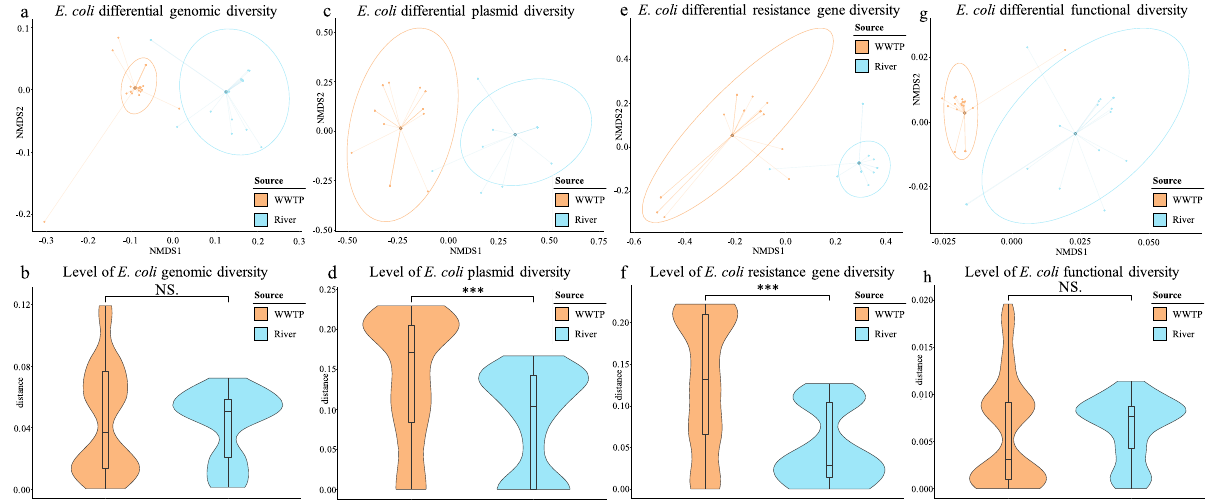
Fig. 3 Non-metric multidimensional scaling (NMDS) and violin plots according to Jaccard distance index and the environment (WWTP and river, indicated by colors). NMDS graphs show the differential content in the total wastewater E. coli population ( n = 25 independent isolates) and river E. coli population ( n = 18 independent isolates), indicating the centroids for the means of each group and clustering them by colored ellipses. Violin plots show medians and quartiles for diversity levels per E. coli ST, comparing them by the origin of the isolates. Highly signi fi cant differences are indicated by ***. Non- signi fi cant differences are indicated by NS. a Differential genomic content based on core-genome analysis. b Level of genomic diversity per E. coli ST based on core-genome analysis. c Differential plasmid content based on plasmid incompatibility groups. d Level of plasmid diversity per E. coli ST based on plasmid incompatibility groups. e Differential antibiotic resistance gene content. f Level of antibiotic resistance gene diversity per E. coli ST. g Differential function content based on function prediction from core-genome analysis (BB1442 was excluded from NMDS graph to optimize the visualization). h Level of function diversity per E. coli ST based on function prediction from core-genome